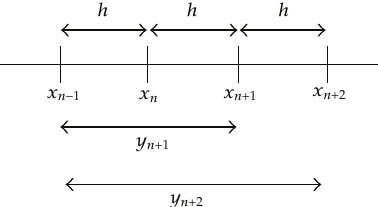
Figure 1: Diagonally Implicit 2-point block method of constant step